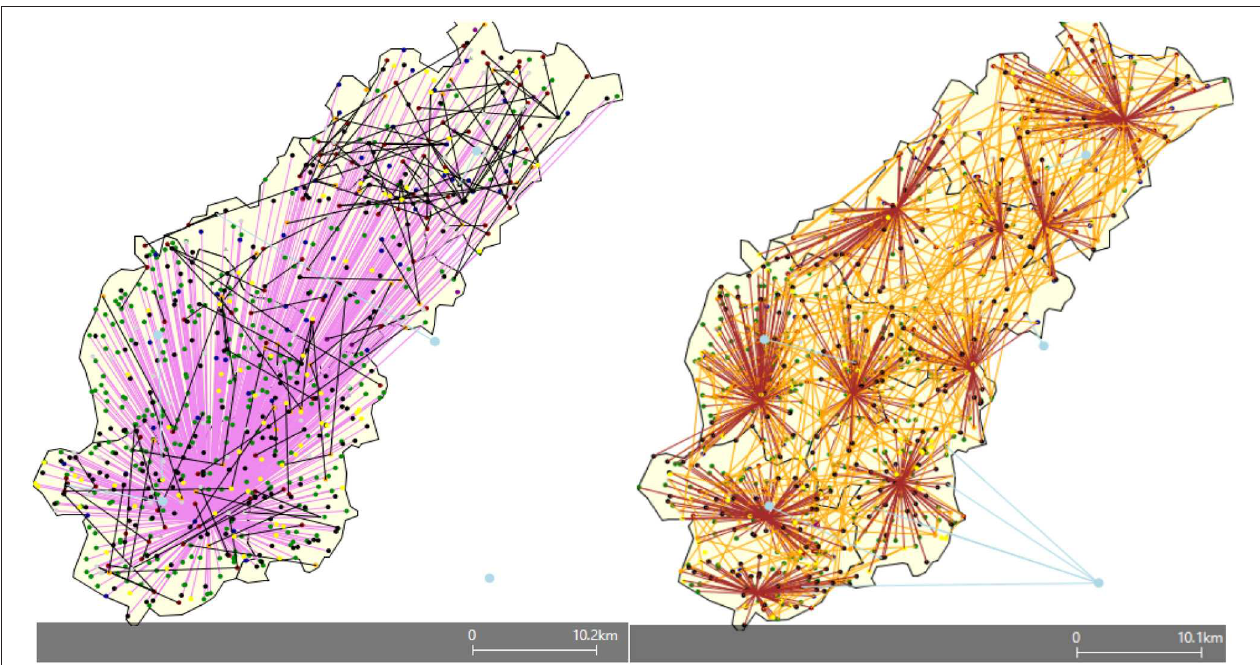
FIGURE 4 | GAMA platform display for local fertilization flows in Ribéracois in two contrasted scenarios: BAU situation on the left and Maximum Circularity on the right. Farm typologies are represented by colored circles: green for arable farms; black for mix farms; red for beef cattle farms; blue for dairy cattle farms; purple for mix cattle farms; gray for ovine and caprine farms; orange for monogastric farms and yellow for horticultural farms. Wastewater treatment station are presented in large blue circles; anaerobic digesters in gray triangles and feed collectors in yellow squares. Material flows are presented in lines joining supplier and demander agents: manure for fertilization flows are in black lines; manure for digestion flows are in brown lines; digestates flows are in orange lines; sewage sludge flows are in blue lines and chemical fertilizer flows in purple lines. Note that manure for digestion returns from digesters to the supplying farm before this farm shares outflows of any surplus digestates to other